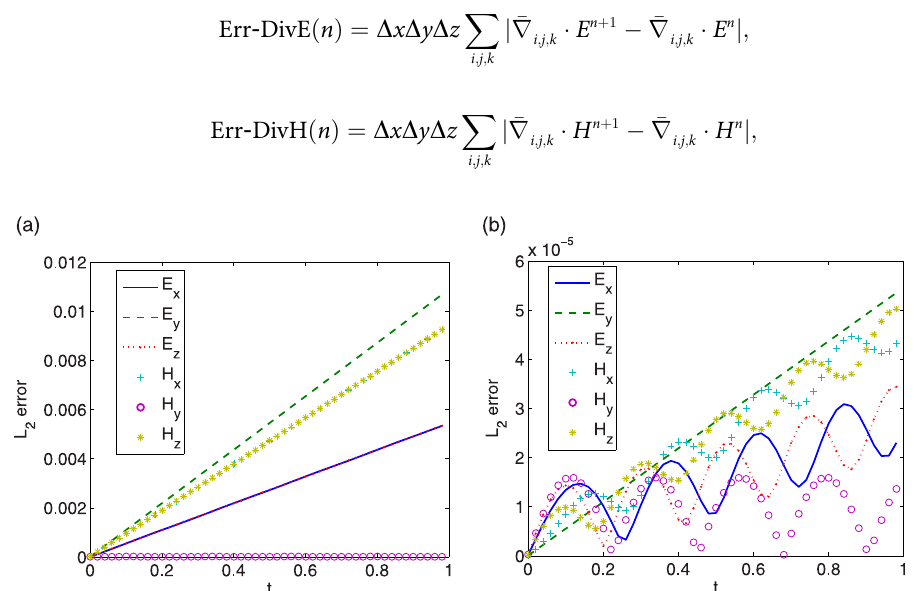
Fig 12. L 2 errors of numerical solutions to LOD central box scheme (left) and LODEFMS scheme (right) in second testing case.